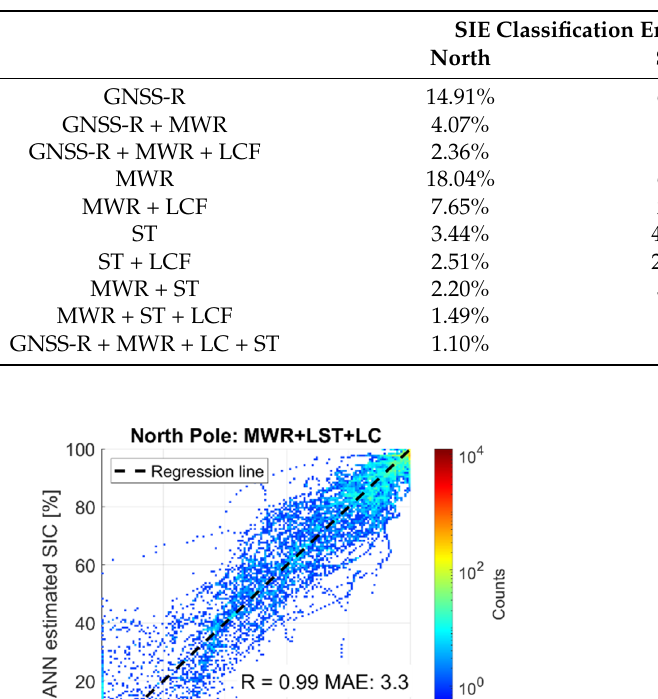
Table 4. GNSS-R NN error with respect to the input variables (II).